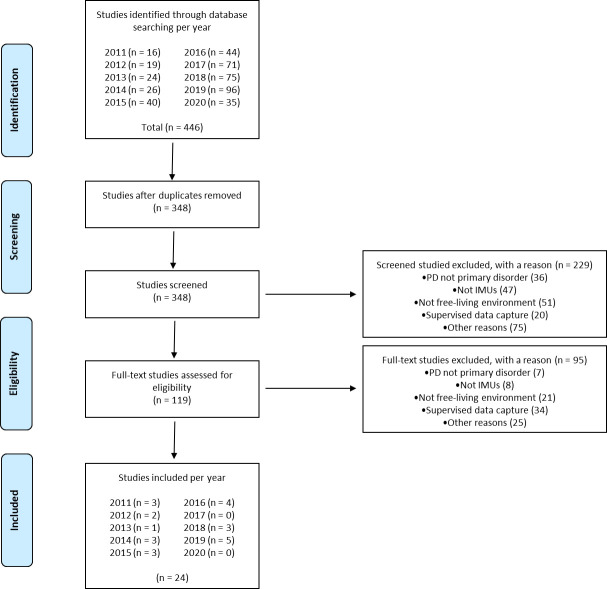
PRISMA flow diagram.